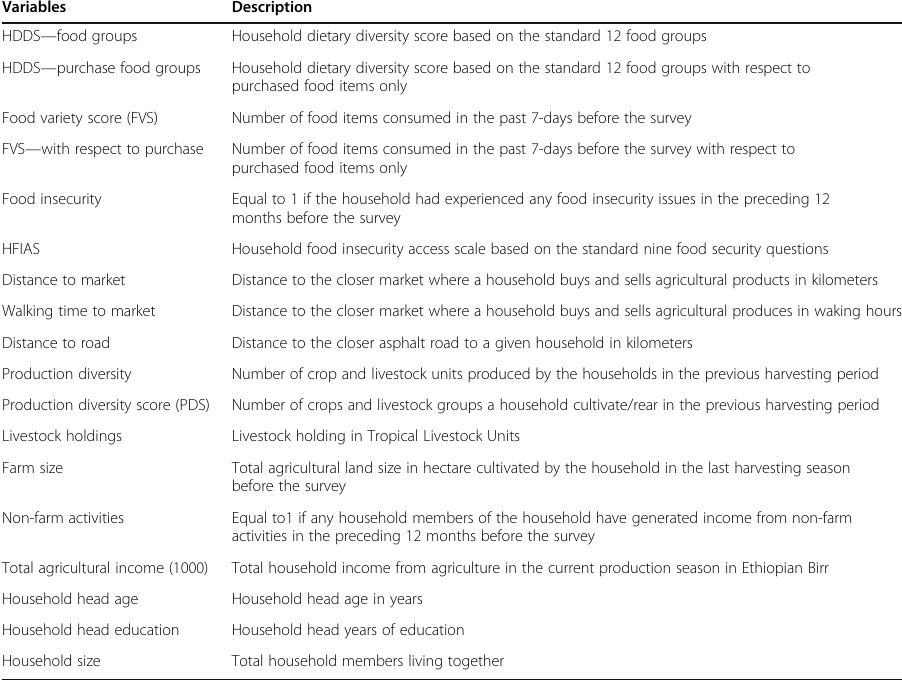
Table 5 Study variable definitions and measurements